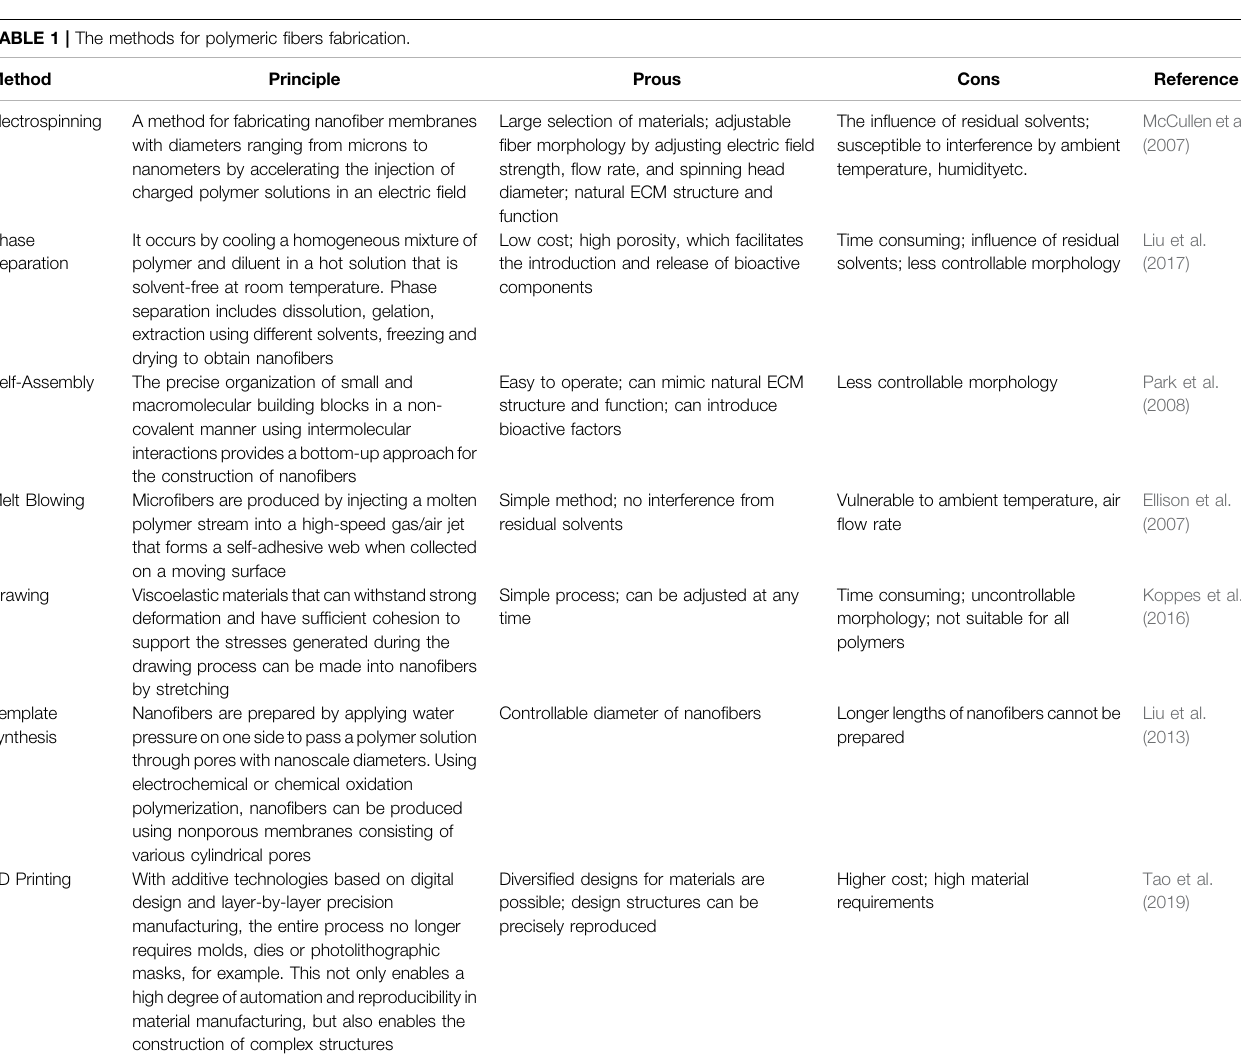
TABLE 1 | The methods for polymeric fi bers